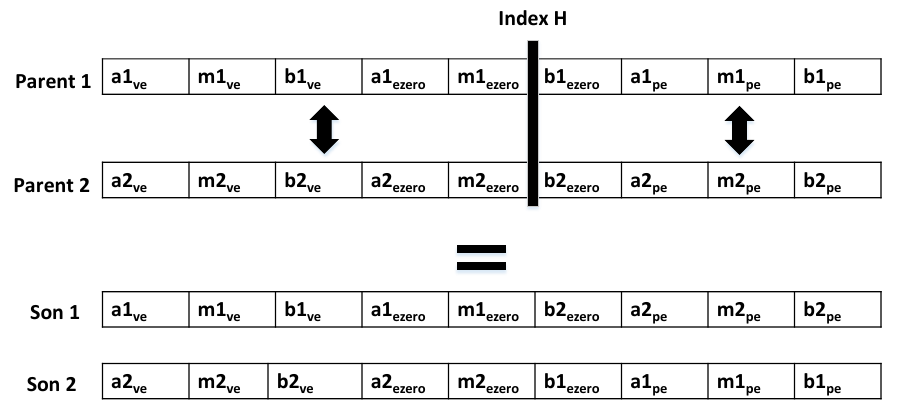
Figure 7. Demonstration of the PMX cross.